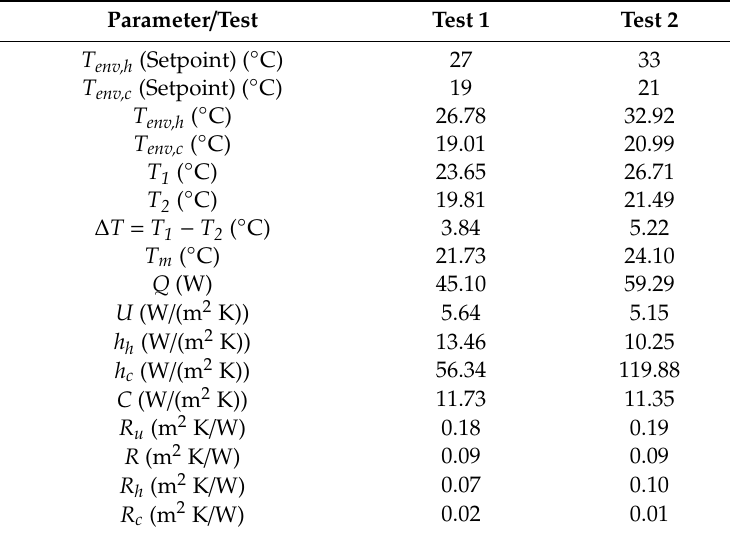
Table 5. Heat transfer quantities for Wall System